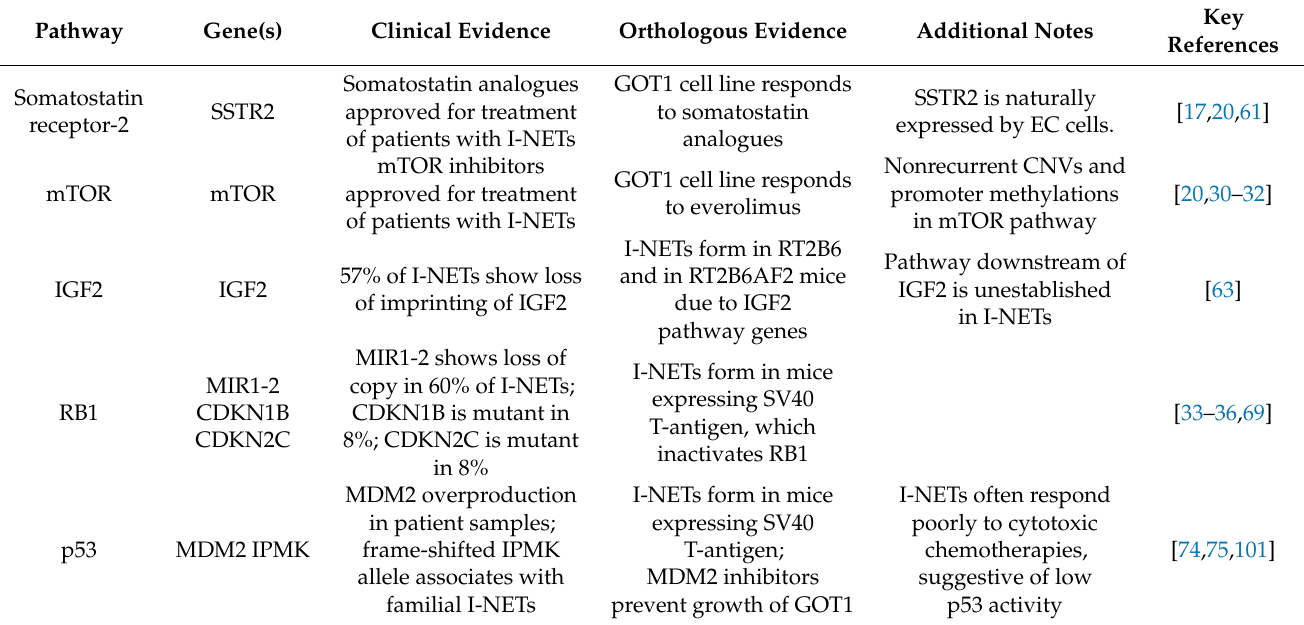
Table 1. Some of the key pathways in Ileal